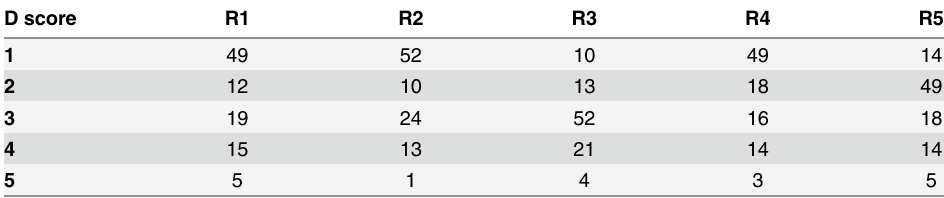
Table 1. Frequency of Deauville (D) scores by reader R1 –